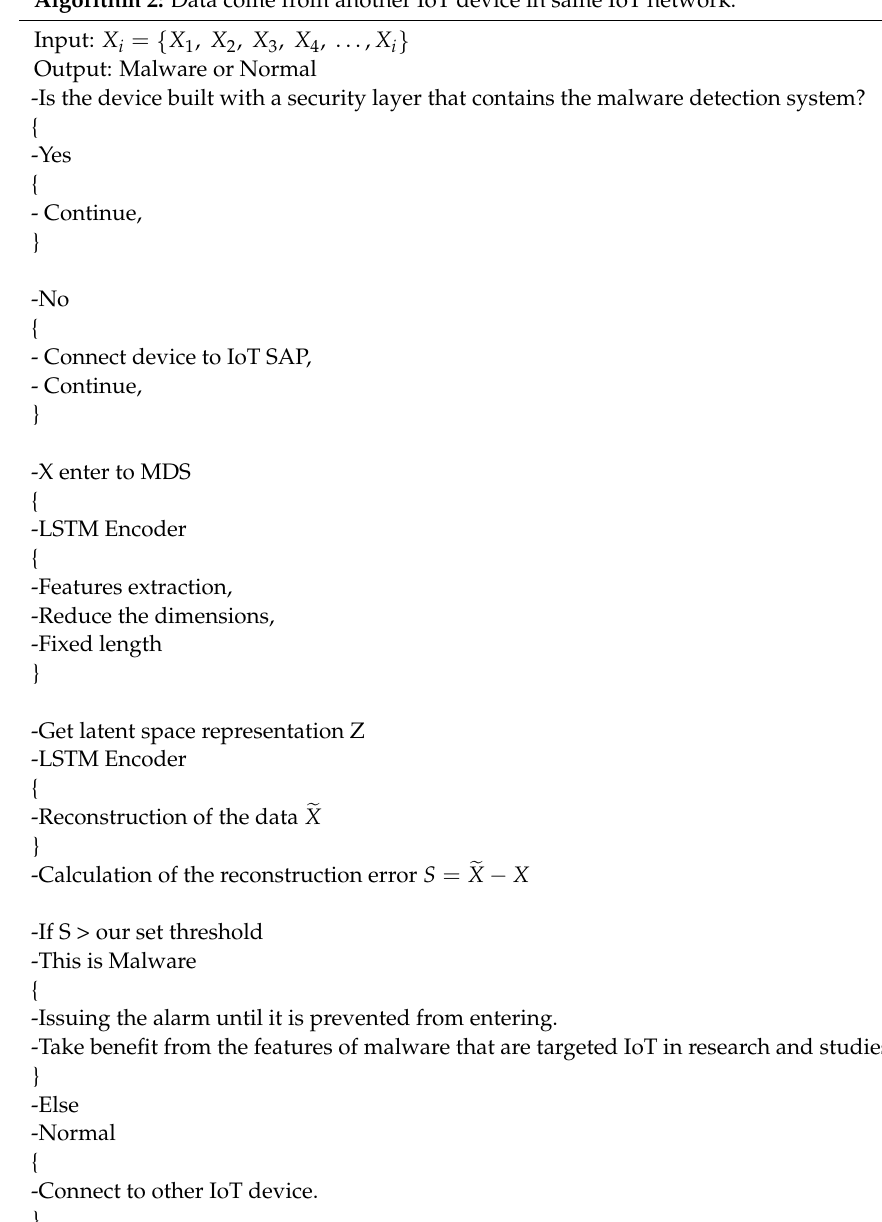
Algorithm 2: Data come from another IoT device in same IoT